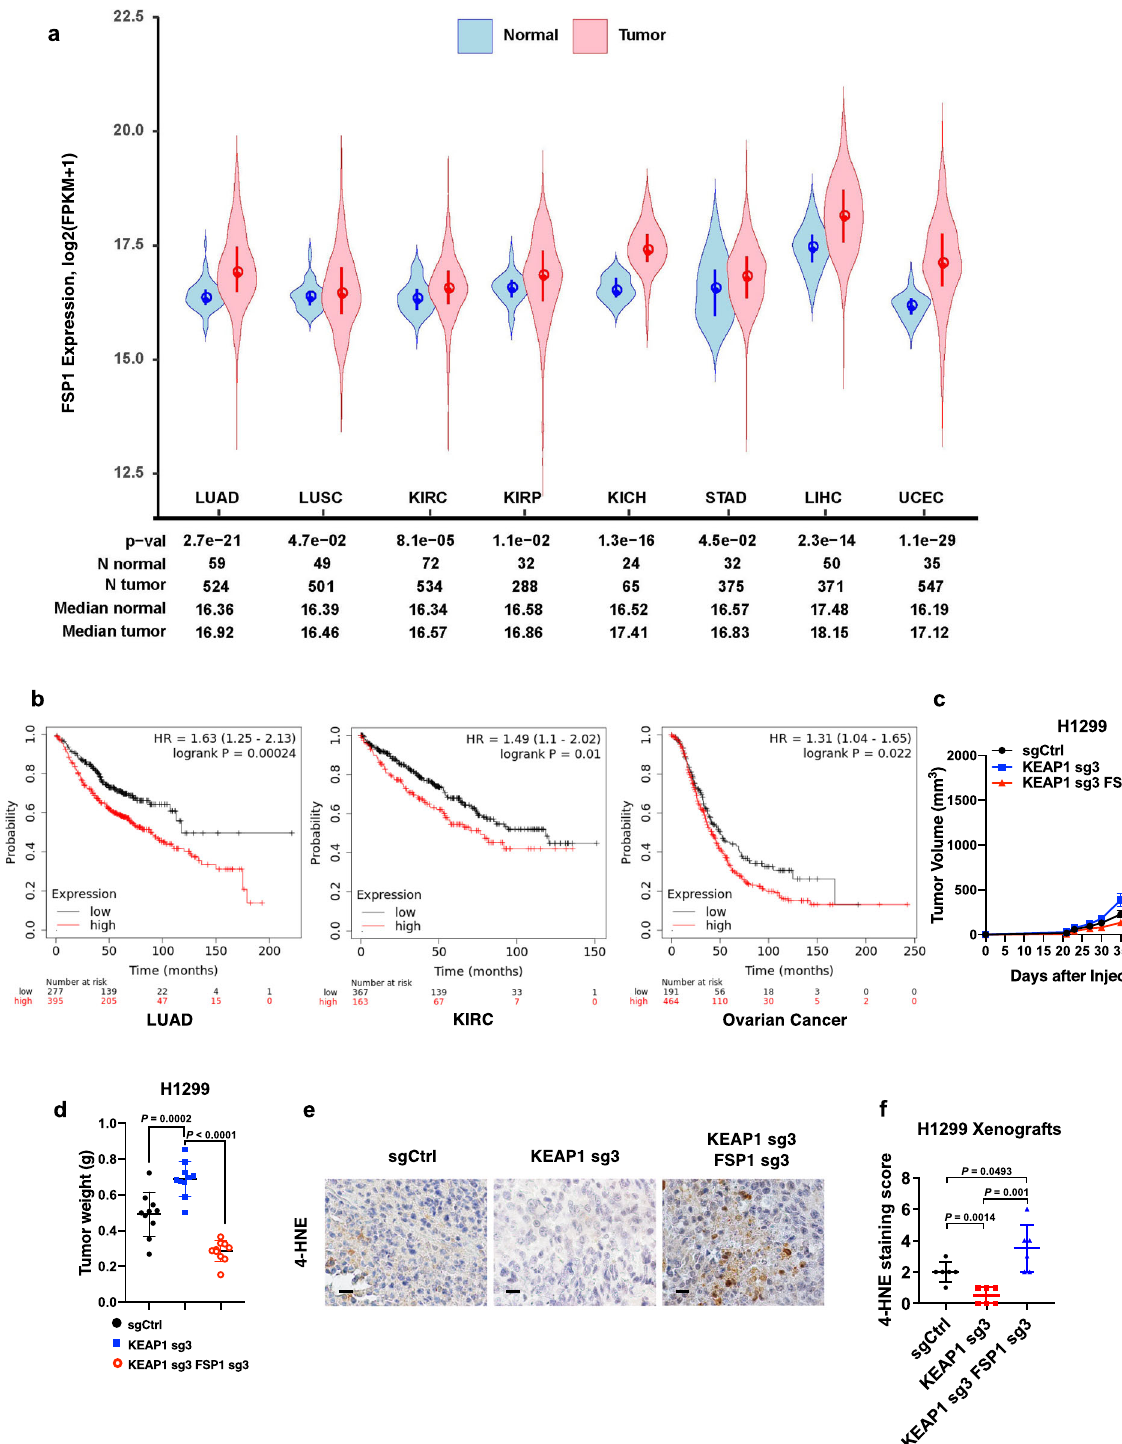
Fig. 4 FSP1 promotes tumorigenesis in KEAP1 de fi cient lung cancer. a FSP1 expression in tumor samples of lung adenocarcinoma (LUAD), lung squamous cell carcinoma (LUSC), kidney renal clear cell carcinoma (KIRC), kidney chromophobe (KICH), liver hepatocellular carcinoma (LIHC), uterine corpus endometrial carcinoma (UCEC), and stomach adenocarcinoma (STAD) vs corresponding normal tissues. b Survival analysis of various cancer types with high and low expression of FSP1 in LUAD, KIRC, and ovarian cancer. c , d Measurement of tumor volumes ( c ) and endpoint tumor weights ( d ) of H1299 xenograft models with indicated genotypes. Error bars are means ± SD, n = 10 tumors. e , f Immunochemistry staining ( e ; scale bars, 20 μ m) and scoring ( f ) of 4-HNE in H1299 xenograft tumors with indicated genotypes. Error bars are means ± SD, n = 6 randomly selected magni fi cation fi elds. Data were presented as (if mentioned otherwise) mean ± SD; n = 3. For d , f , P value was determined by two-tailed unpaired Student ’ s t -test; ns not signi fi cant. Source data are provided as a Source Data fi